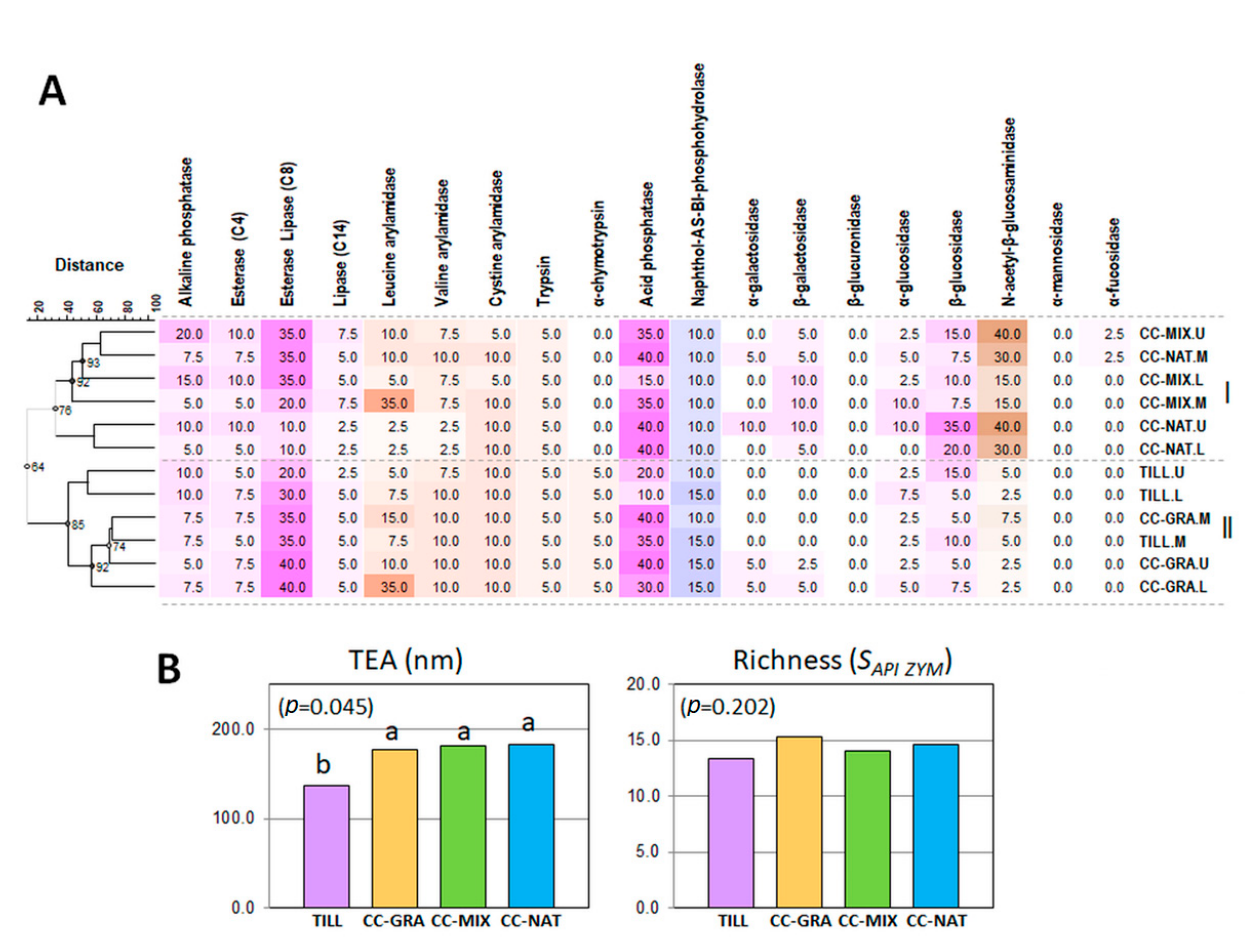
Figure 3. Enzymatic activities as measured by the API ZYM™ strip of an olive orchard soil under different cover crop managements (TILL: tillage, CC-GRA: sown cover crop with gramineous and CC-MIX: sown cover crop with a mixture of species) and CC-NAT (cover crop with spontaneous vegetation) and for each sampling point on the slope (U: upper, M: middle and L: lower). ( A ) Cluster analysis of combined data using the Ward algorithm applied to the similarity matrix generated from the intensity of the different activities (from 0 to 40 nmol) by using the Bray–Curtis distance coefficient. Intensity of color in the figure is proportional to activity. Cophenetic correlation values are indicated in each node. ( B ) Mean comparison of the total enzymatic activity (TEA) measured in nanometers that could be achieved and of the number of enzymatic activities (richness, S API ZYM ) was performed using the rank-based Kruskal–Wallis test. Dunn’s all-pairwise multiple comparison test was applied when appropriate ( p < 0.05). (Different letters indicate significant differences p <